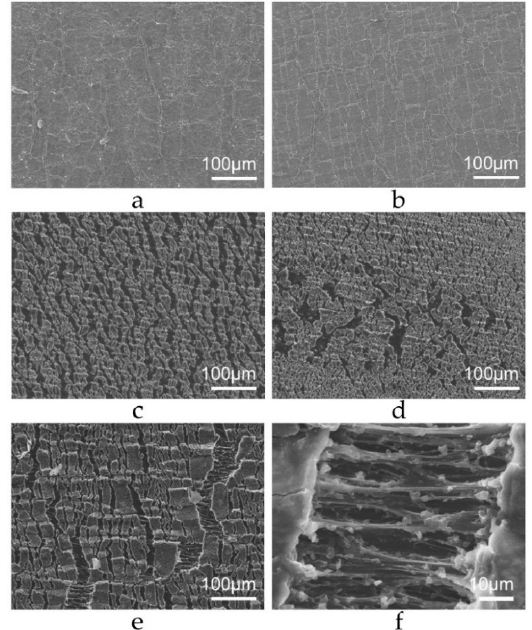
Figure 4. SEM micrographs obtained from different spots of the same rubber sample. In images ( a , b ),